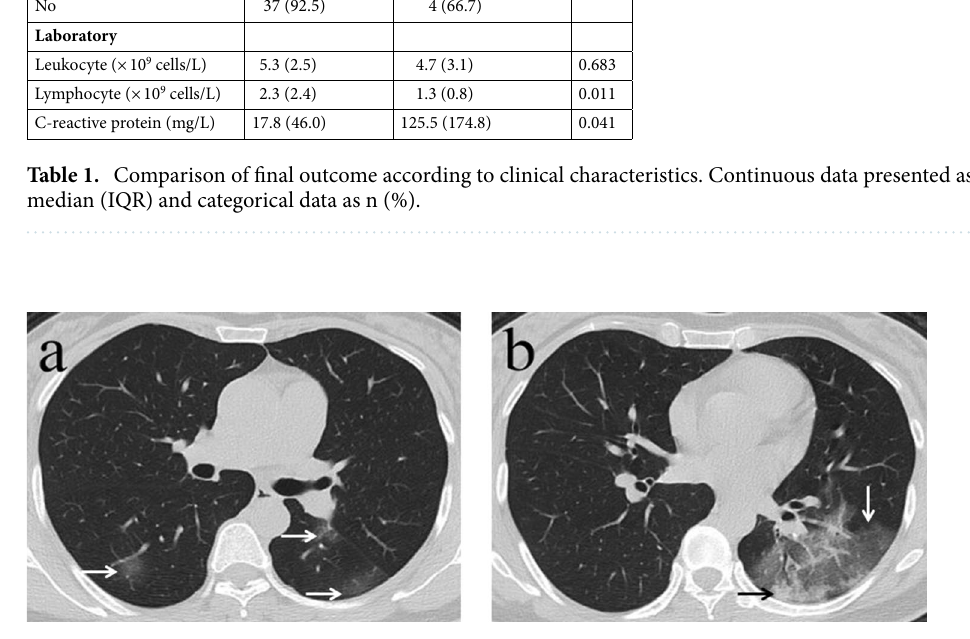
Figure 1. A 45-year-old woman with history of recent travel to Wuhan presented with fever for 1 day. ( a , b ) Non-contrast enhanced chest computed tomography (CT) showed multiple peripheral patchy ground glass opacities in both lower lobes (white arrows). CT scan also demonstrated consolidation in the left lower lobe (black arrow). CT involvement score was